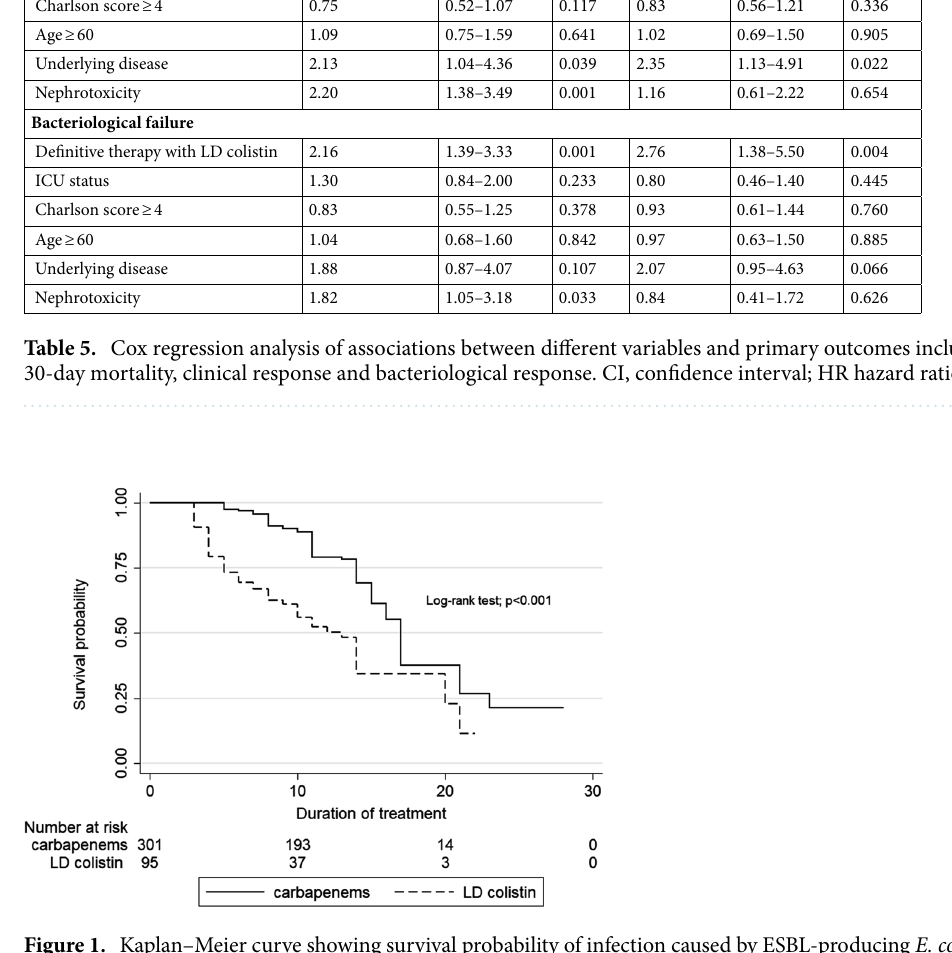
Figure 1. Kaplan–Meier curve showing survival probability of infection caused by ESBL-producing E. coli and K. pneumoniae according to LD colistin and carbapenems